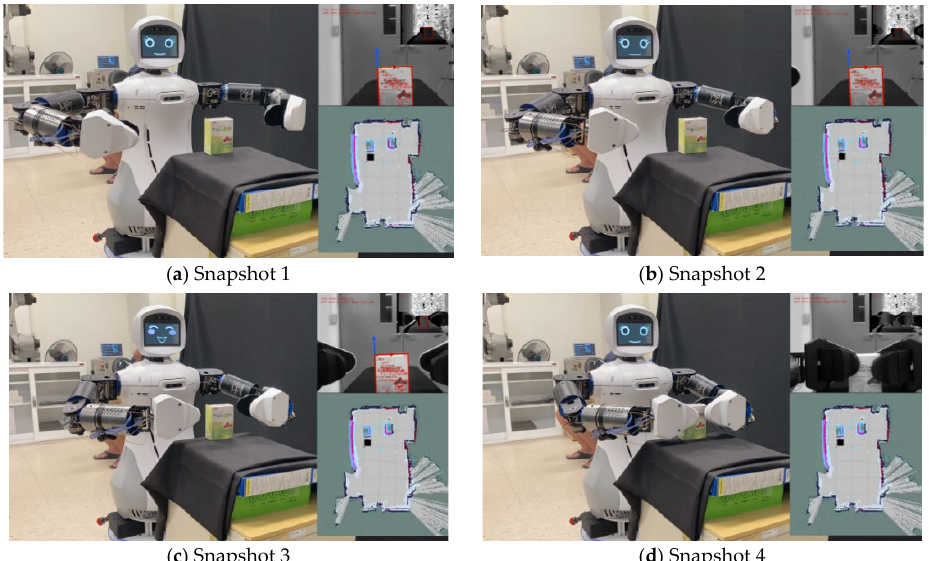
Figure 17. Snapshots of the dual-arm robot using a hybrid, model-based tracking method to track objects using its arms. ( a – d ) The process for the robotic grasping.